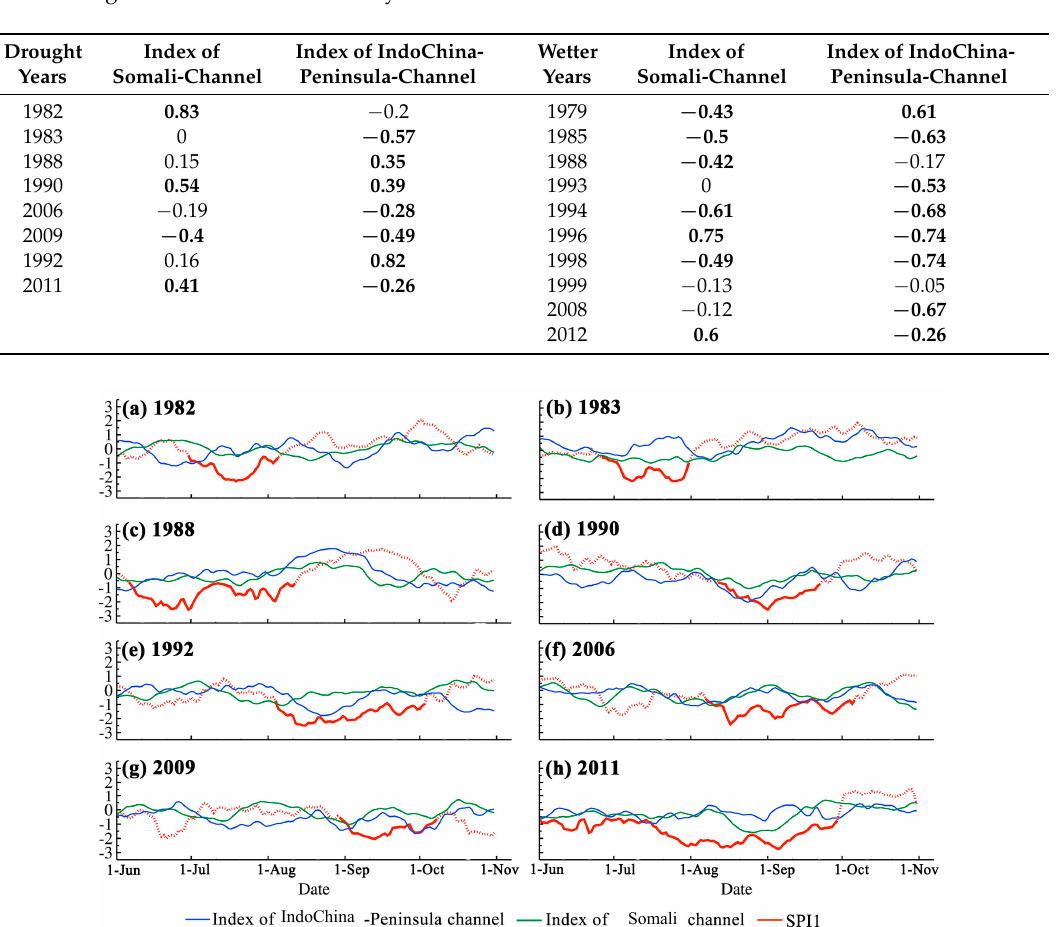
Table 2. Synchronous correlation coefficients between indices of geographical water vapor transport (WVT) anomalies and SPI1 during severe drought and wetter processes. The bold values indicate those exceeding the 95% confidence level by Student’s t test.